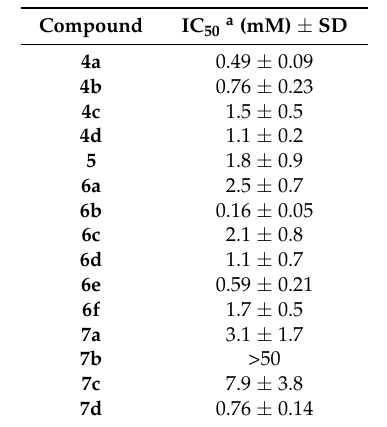
Table 1. Antifungal activity of the compounds 4 – 7 against Fusarium oxysporum .